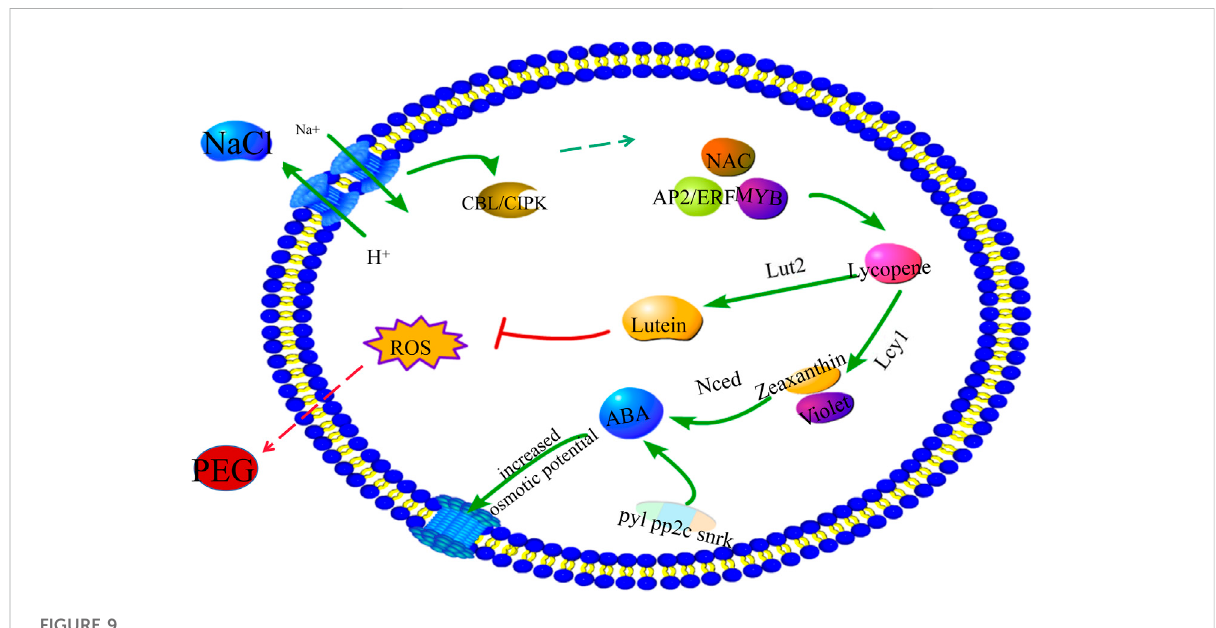
FIGURE 9 Molecular mechanism of carotenoids enhancing drought